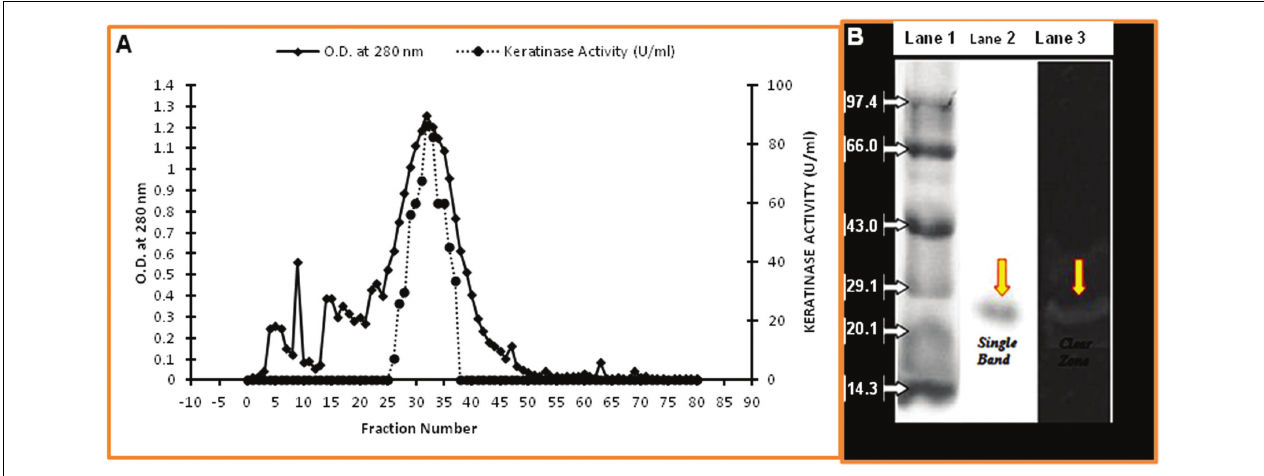
FIGURE 4 | Purification of keratinase from Thermoactinomyces sp. RM4. (A) Elution profile of keratinase of Thermoactinomyces sp. strain RM4 in Sephadex G-75 column; (B) SDS–PAGE assay and the activity of purified Keratinase from Thermoactinomyces sp. RM4. Lane1: standard protein markers; Lane 2: purified proteases; Lane 3: zymography of purified